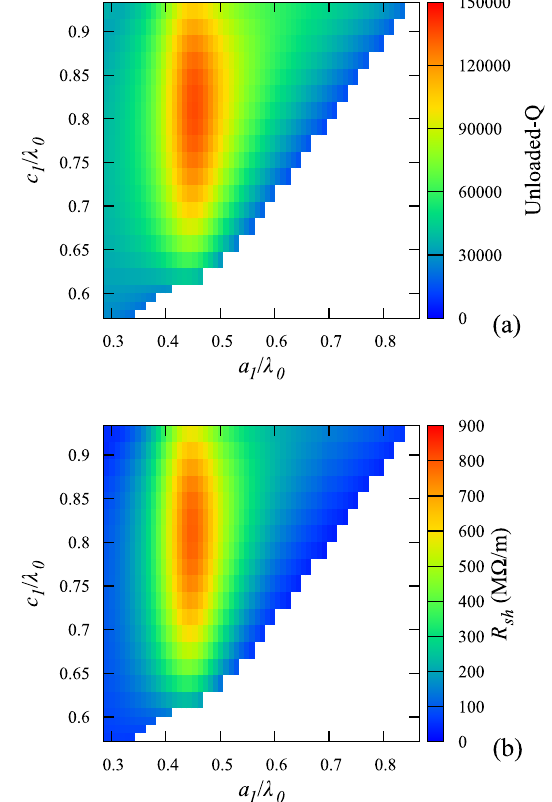
FIG. 3. (a) The dependence of unloaded quality factor of the DAA type regular cell on the geometrical parameters, a 1 and c 1 . (b) The dependence of shunt impedance of the DAA type regular cell on the geometrical parameters, a 1 and c 1 .